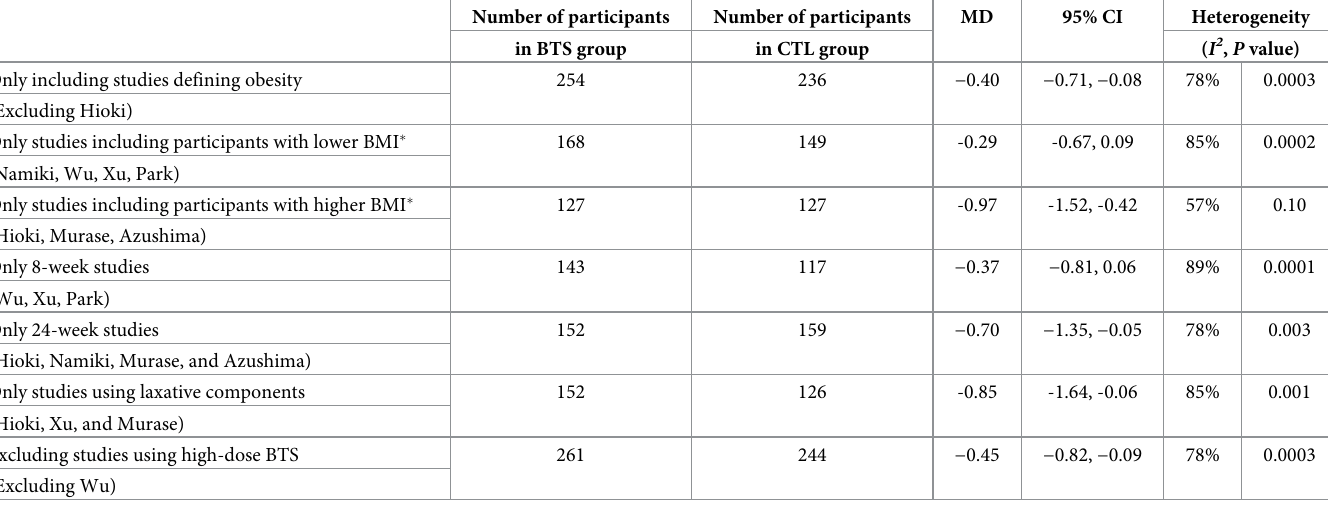
Table 3. Sensitivity analyses for body mass